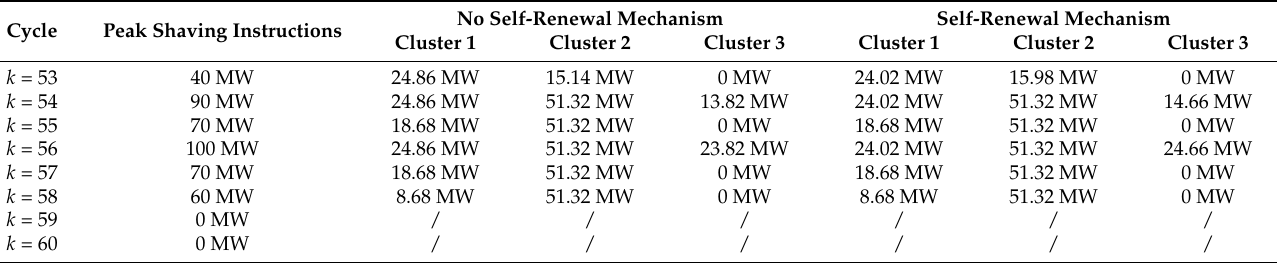
Table 5. Comparison of peak shaving tasks allocation.